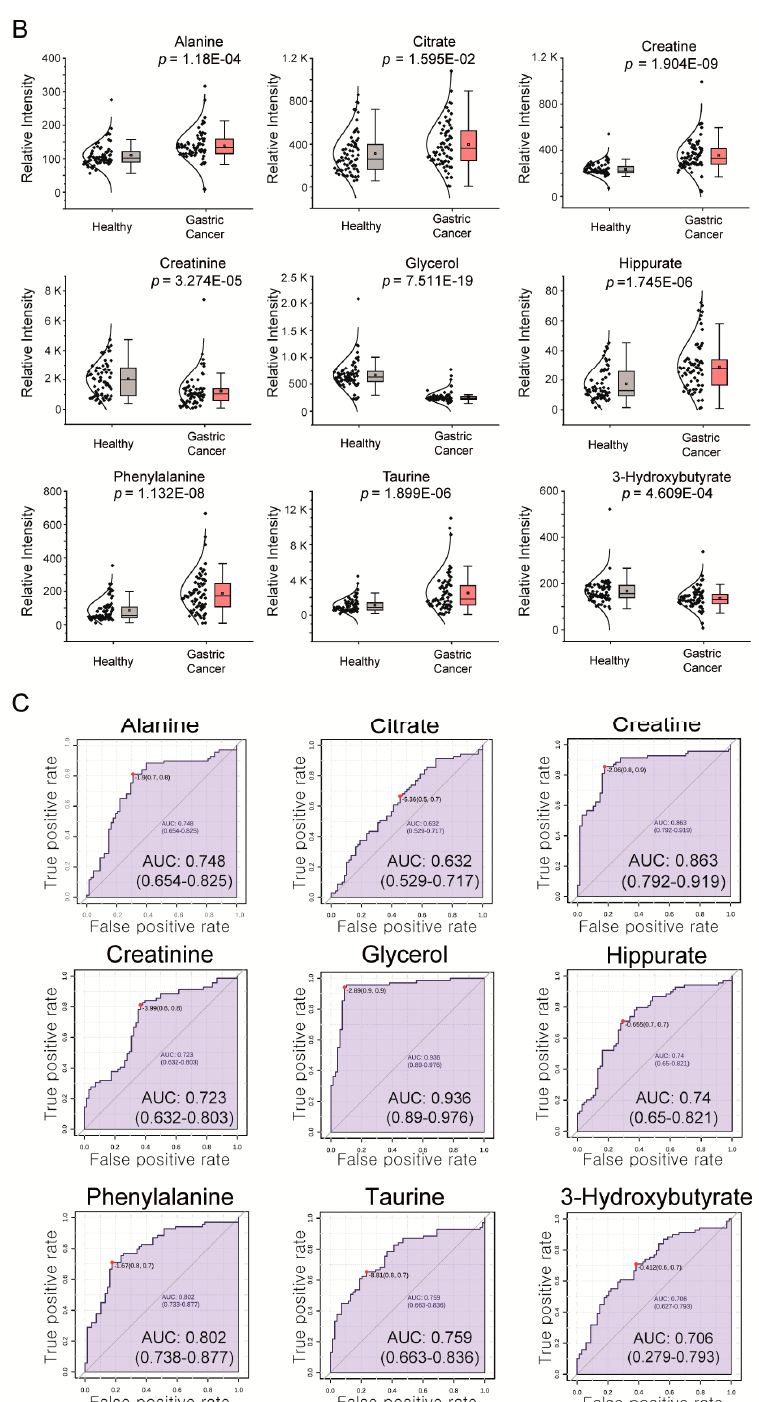
Figure 2. Identification of contributing metabolites by statistical total correlation spectroscopy, their relative levels in urine samples, and ROC analysis. ( A ) The color scale P(corr)p on the right represents a modeled correlation, and Pp represents a modeled covariation. The names are indicated for metabolites with noticeable signals, whose distribution was different between the healthy control and gastric cancer groups. ( B ) Relative concentrations of identified metabolites in urine samples from healthy controls and patients with gastric cancer and associated p -values. The shown false discovery rate (FDR)-adjusted p -values were acquired through the online statistical analysis tool Metaboanalyst (www.metaboanalyst.ca). ( C ) ROC curves of each identified metabolite, with area under the curve (AUC), sensitivity, and specificity.